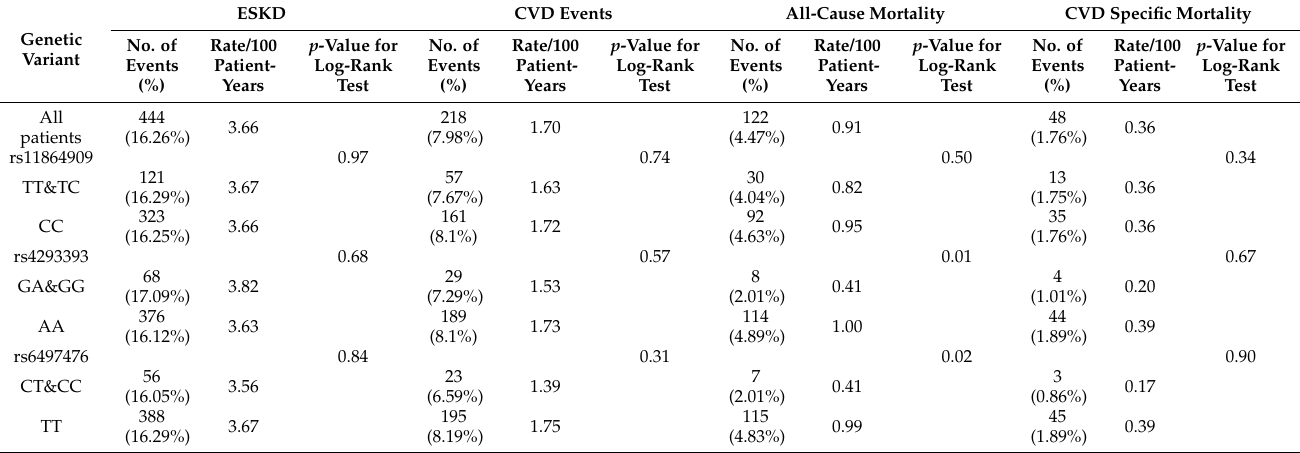
Table 3. Incidence rates for outcomes among all study participants and stratified by genotypes of variants. Genetic Variant